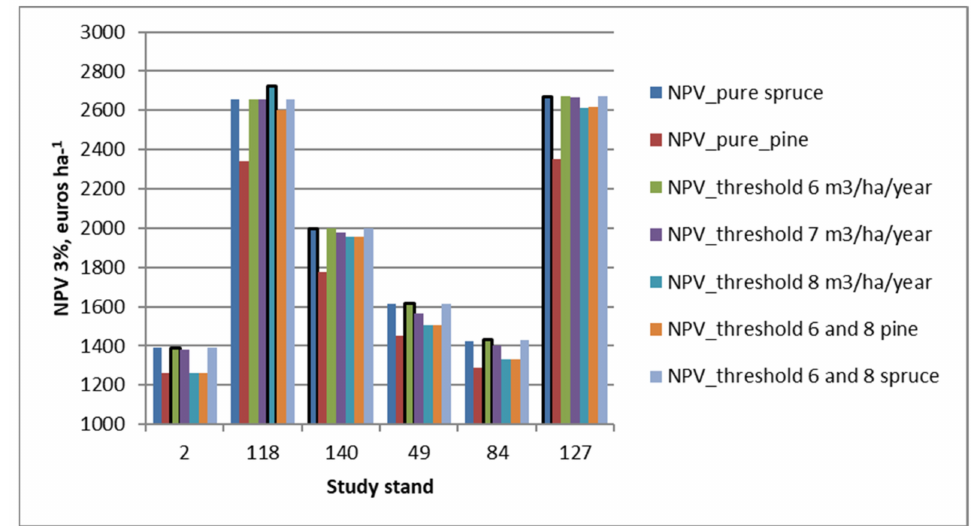
Figure 3. NPVs (3%) with seven different micro-stand options in the study stands. The highest bar has bolded frames. Study stands were arranged in ascending order by